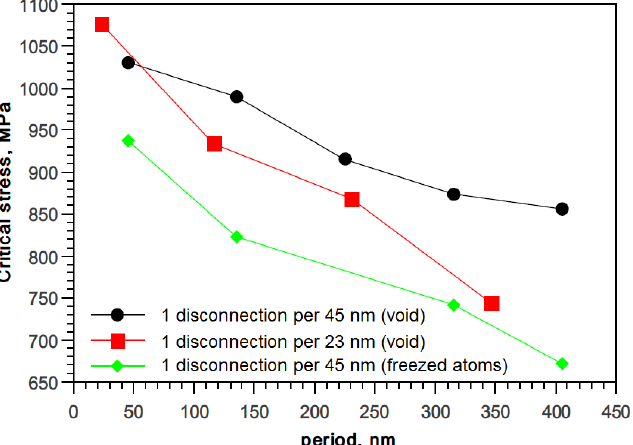
Figure 5. Dependence of critical stresses on the distance (period) between obstacles for different densities disconnections and kinds of obstacle (cavity or non-sheared obstacles). densities disconnections and kinds of obstacle (cavity or non-sheared